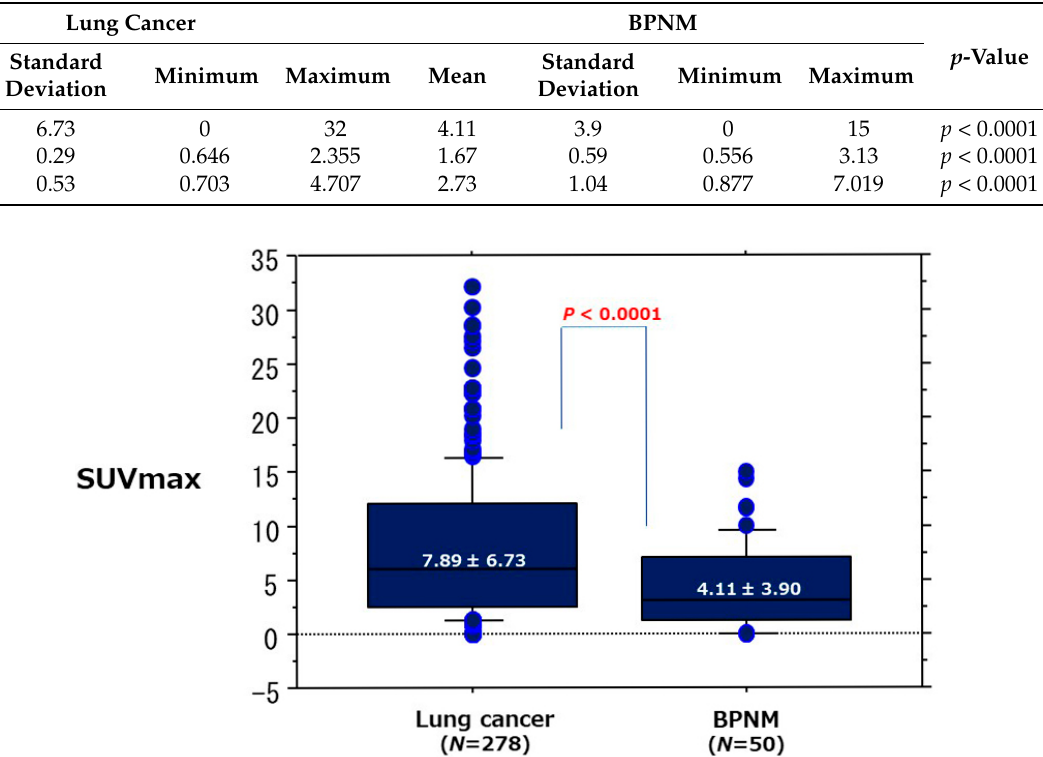
Figure 8. Comparison of SUVmax between lung cancer and BPNM. The mean SUVmax (7.89 ± 6.73) of lung cancer was significantly higher than that (4.11 ± 3.90) of BPNM ( p < 0.0001).